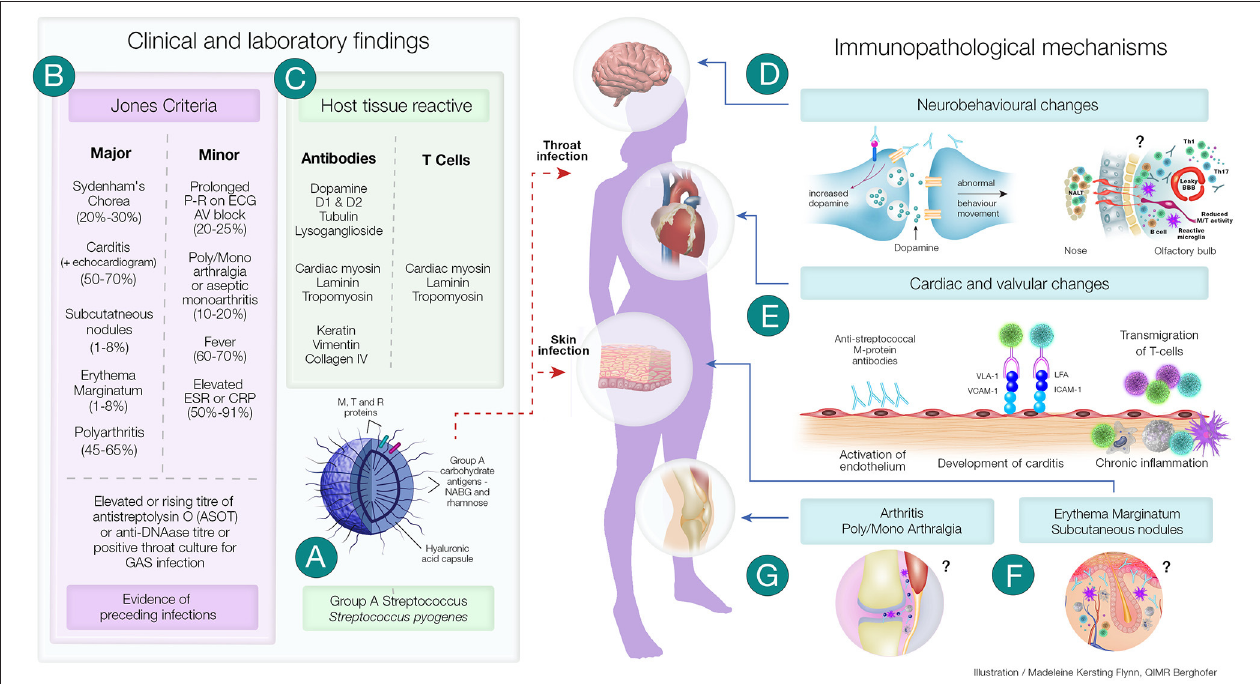
FIGURE 1 | Clinical and Immunopathological Features of Acute Rheumatic Fever and its Complications. (A) Group A streptococci (GAS) have several virulence factors that enables it cause a variety of superficial and deep-tissue infections. In a proportion of individuals following pharyngitis or pyoderma, one of the post-streptococcal autoimmune sequalae that can develop is acute rheumatic fever (ARF). (B) A group of universally accepted clinical manifestations and non-specific laboratory investigations form the Revised Jones Criteria. Laboratory investigations include evidence of recent streptococcal infection (as assessed by rising titre of anti Streptolysin O (ASOT) or anti-DNase titre or positive throat culture for streptococcal infection). Evidence of preceding streptococcal infection in addition to either two major or one major and two minor criteria confirms the diagnosis of ARF. (C) Both clinical and experimental studies have shown the presence of antibodies and CD4 + T cells generated in ARF have the ability to cross-react with both streptococcal proteins and host tissue proteins. The autoimmune inflammatory process initiated by these antibodies and T cells lead to several of the immunopathological changes observed in ARF. (D) Sydenham’s Chorea, a group of neurobehavioral abnormalities observed in ARF has been found to involve anti-dopamine, anti- β -tubulin and anti-lysoganglioside antibodies reacting with D1 and D2 dopamine receptors, signalling kinases and ion channels and causing these abnormalities. Recent studies have also shown that the CD4 + T cells may be involved in breaching the blood brain barrier and facilitating the entry of antibodies and inflammatory cells. (E) Streptococcus specific antibodies can upregulate VCAM-1 and ICAM-1 on vascular and valvular endothelial cell. Activation of these cells lead to transmigration of activated streptococci specific T-cells into heart tissue leading to cross-reactive responses with tissue proteins perpetuating inflammatory responses including neovascularisation and the appearance of granulomatous lesions in cardiac tissue. (F) Although direct experimental evidence is space, anti-streptococcal antibodies that cross-react with laminin, tropomyosin, vimentin and keratin in the skin may cause the characteristic rash—erythema marginatum observed in ARF. Furthermore, the formation of subcutaneous nodules may be due to delayed hypersensitivity type responses against streptococcal antigens. (G) Anti-streptococcal antibodies could also form immune complexes which bind to the synovial membrane and/or collagen in joints leading to inflammation of the synovial tissue causing arthralgia and arthritis. Repetitive streptococcal infections drive the autoimmune process leading to chronic inflammation and carditis, culminating in rheumatic heart disease and if untreated it is followed by congestive cardiac failure and death. ? Mechanisms not well-characterised; ICAM-1, Intercellular adhesion molecule-1; LFA, Leukocyte associated function antigen; Jones Criteria, (% of patients presenting with the specific feature); Th1 and Th17 CD4 + , T cell subsets; VLA-1, Very late antigen-1; VCAM-1, Vascular cell adhesion